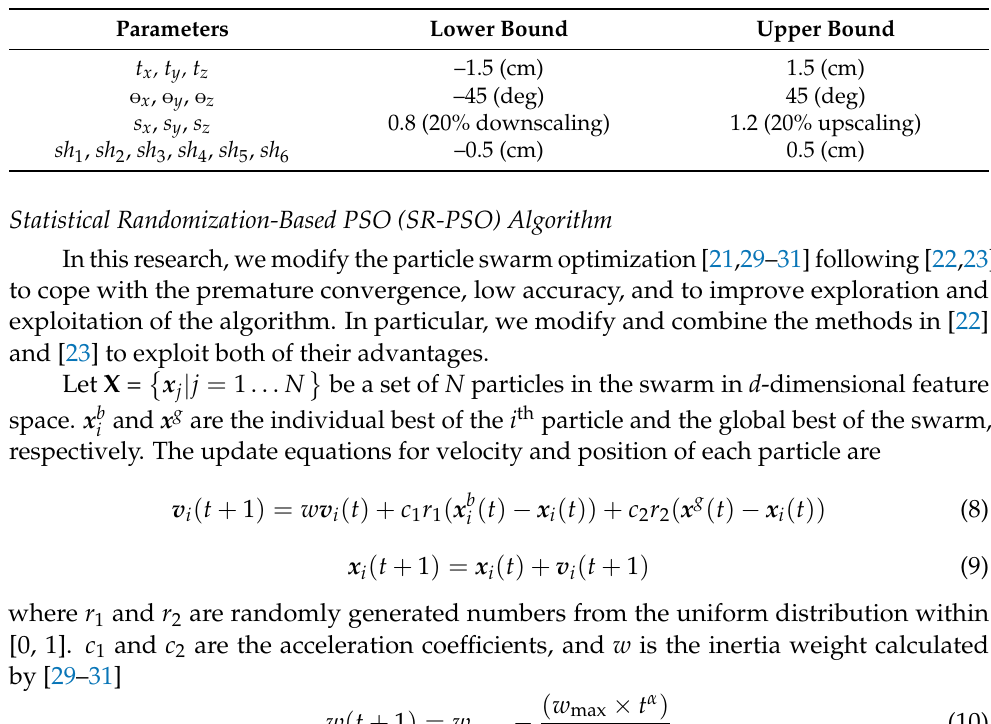
Table 1. Parameters boundaries in optimization